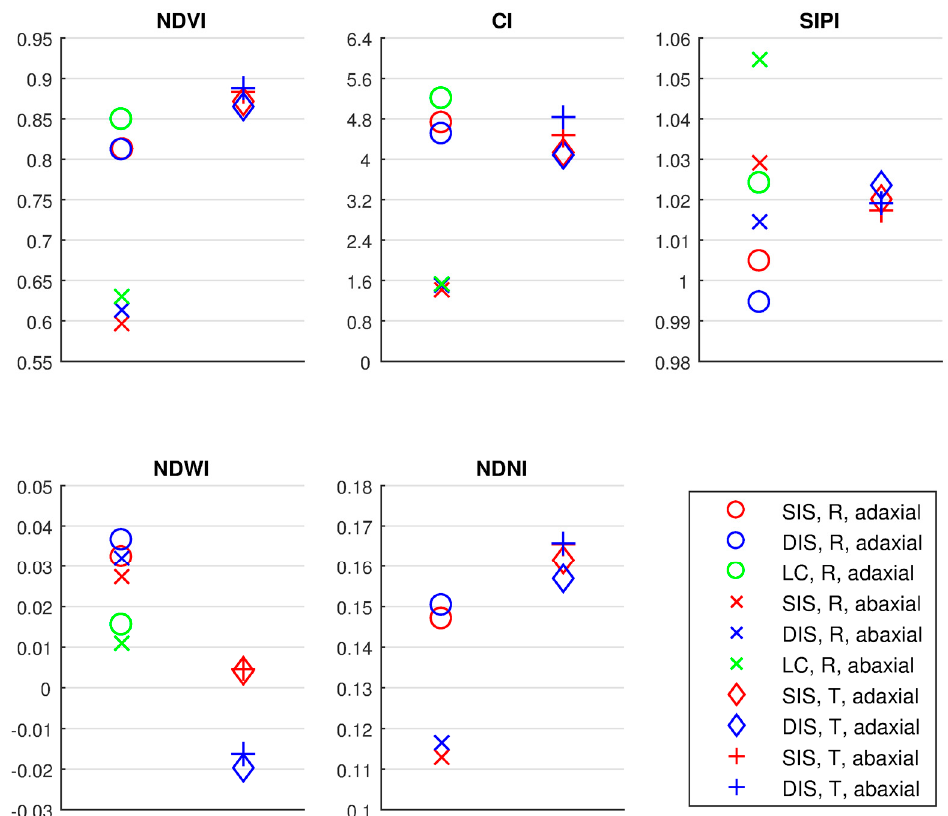
Figure 6. Dependence of spectral indices of birch leaves on measurement method, measured quantity (reflectance or transmittance), and leaf side. The values shown are mean values of indices calculated from the measured spectra (18 spectra per method). SIS = single integrating sphere, DIS = double integrating sphere, LC = leaf clip, R = reflectance, T = transmittance.